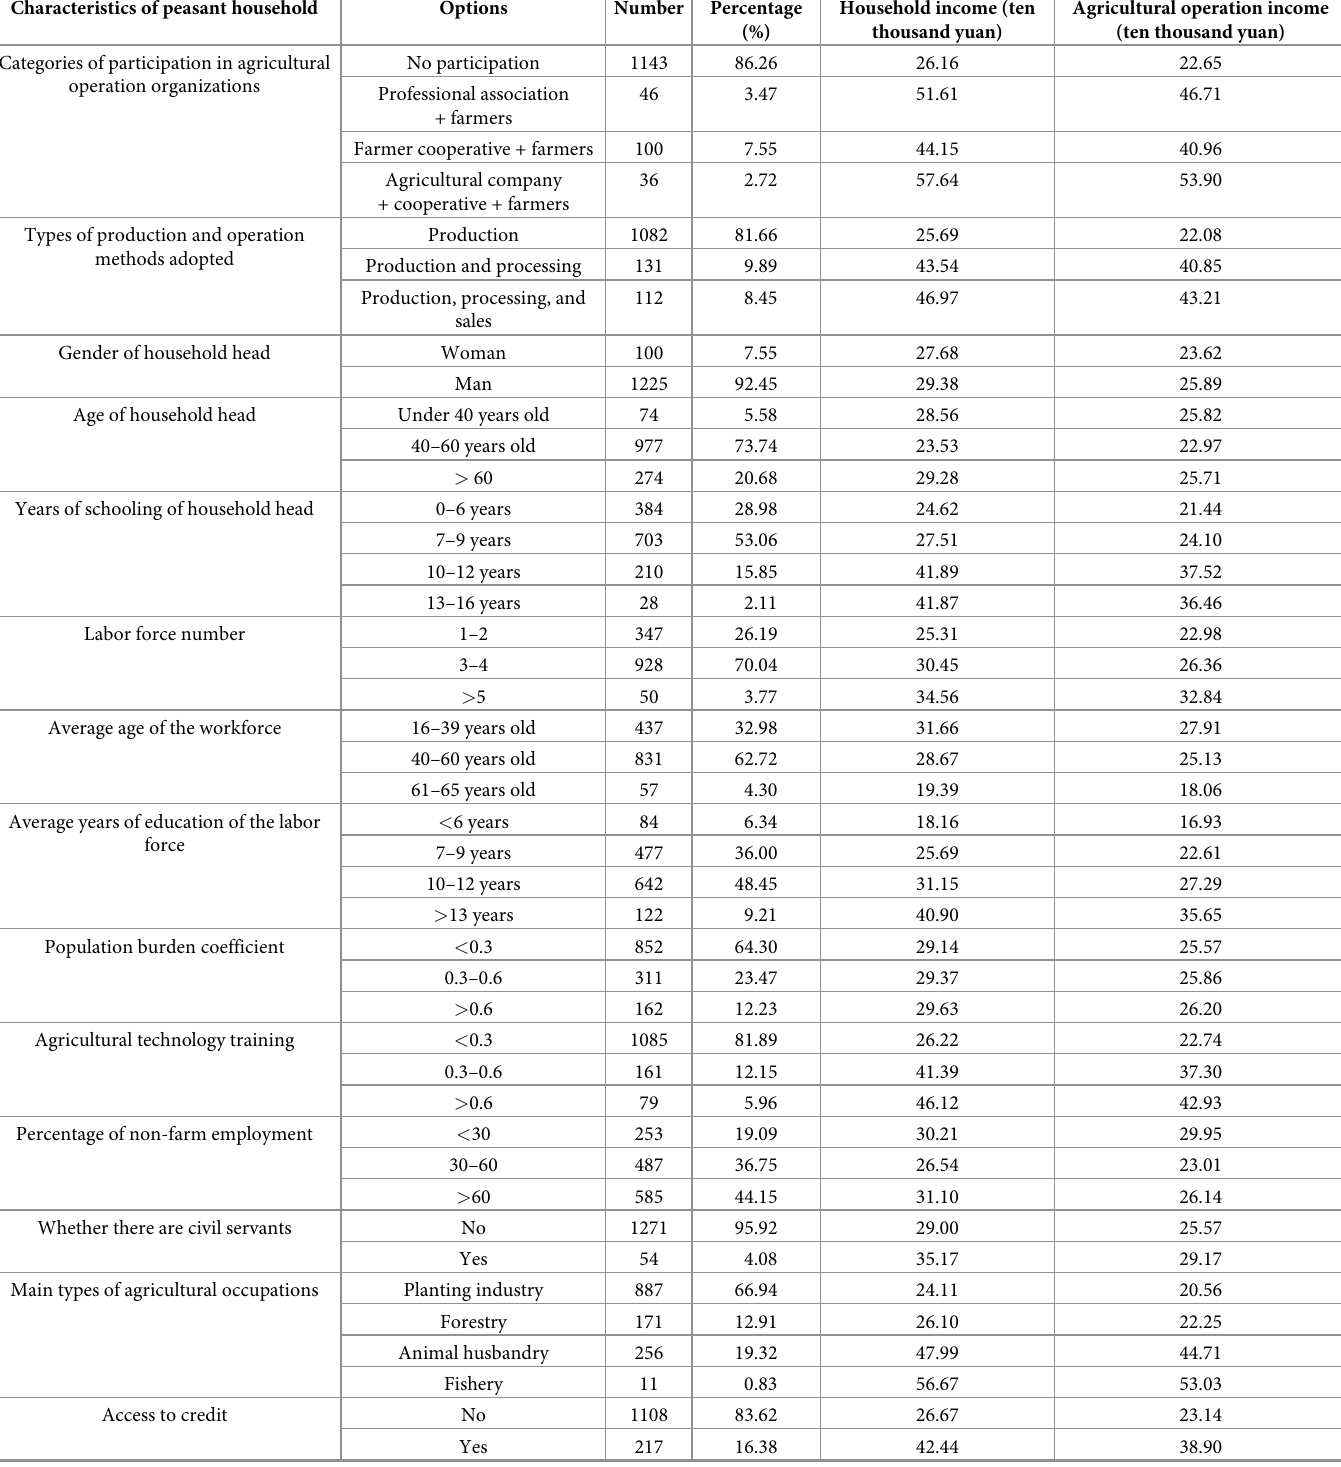
Table 1. Differences in sample farmers’ incomes by household characteristics. Characteristics of peasant